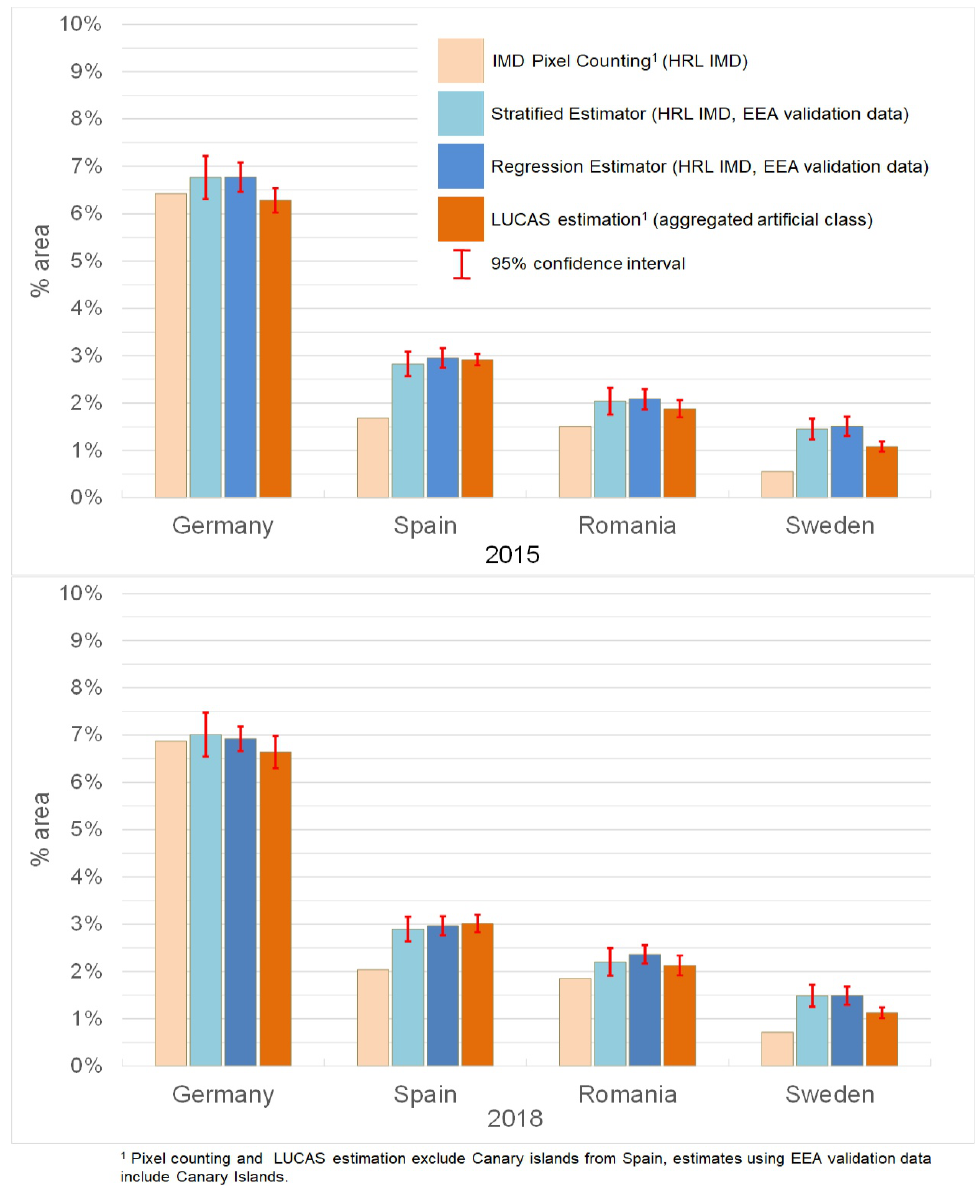
Figure 2. Results of impervious area estimation using different